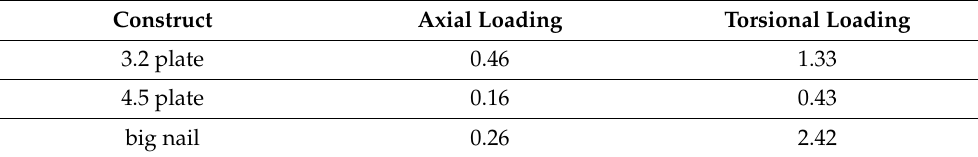
Table 1. Mean total interfragmentary motion in mm by construct and loading directions. The big nail stands for exchange medullary nail, the 3.2 plate stands for small augmentative plate, and the 4.5 plate stands for large augmentative